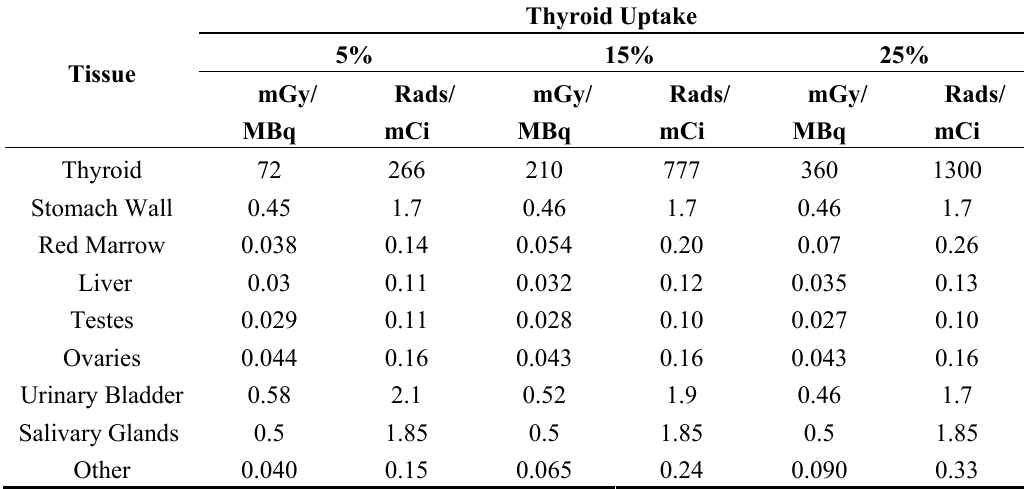
Table 7. The radiation dosimetry of 131 I administration to a euthyroid patient average weight (70 kg) in both milligray (mGy) per megabecquerel (MBq) and rad per millicurie